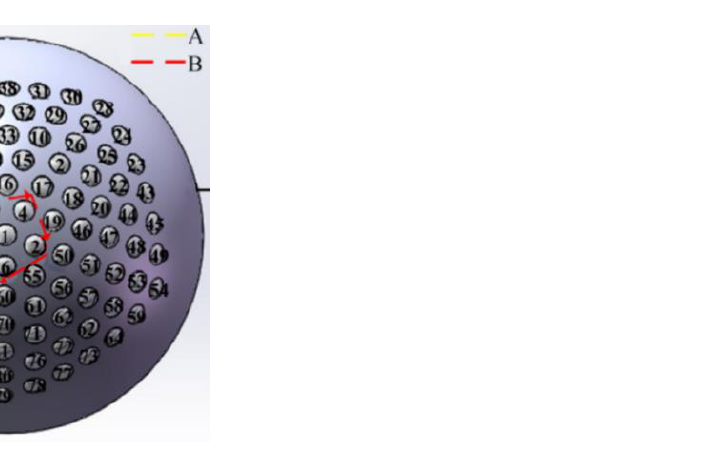
Figure 3. Structure of curved compound eye camera [44]: regular pentagonal arrangement ( A ) and regular hexagonal arrangement ( B ).